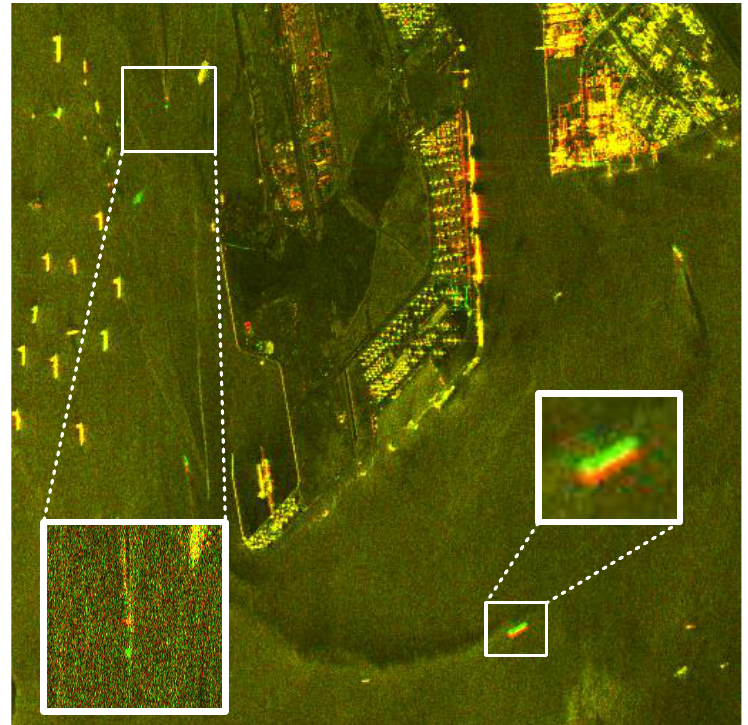
Figure 9. Color composite of fore (red) and aft (green) zoom images of a TerraSAR-X BiDi acquisition of Singapore. The azimuth direction is on the left, from bottom to top. Time lag between fore and aft image is 7.2 s. Further zooms of a small fast and a large ship in the white frames.